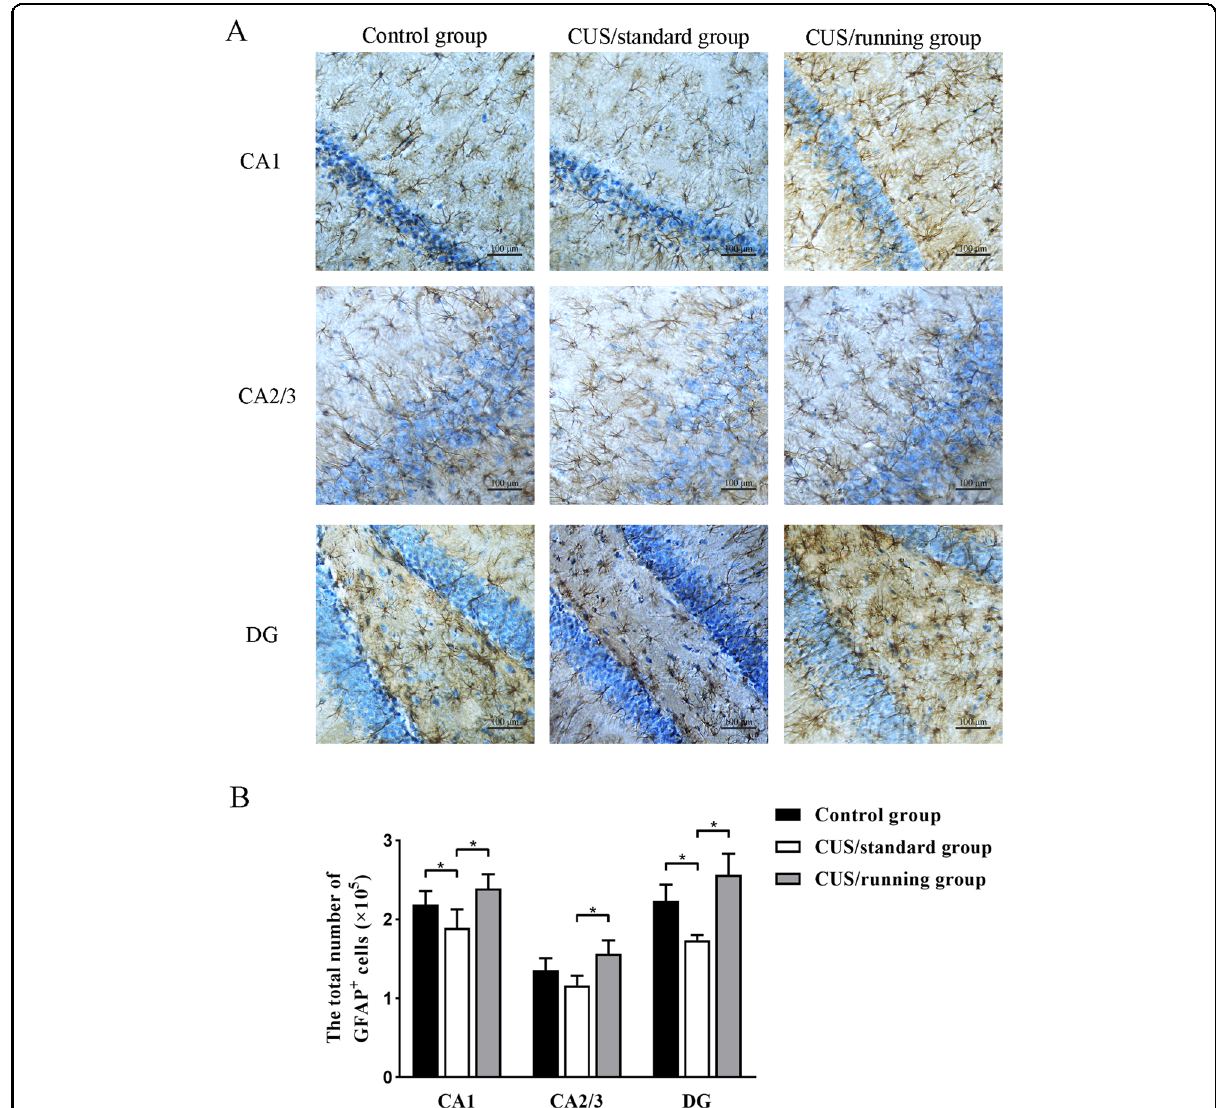
Fig. 4 The positive effects of running exercise on the total number of GFAP + cells in the hippocampus of CUS rats. A Representative pictures of immunohistochemical staining with an anti-GFAP antibody in the three subregions of the hippocampus in the control group, CUS/standard group, and the CUS/running group. Bar = 100 μ m. B The total number of GFAP + cells in the CA1 region, CA2/3 region and DG in the control group ( n = 5), the CUS/standard group ( n = 5), and the CUS/cunning group ( n = 5) (mean ± SD). Asterisk indicates p < 0.05. CUS chronic unpredictable stress, GFAP glial fi brillary acidic